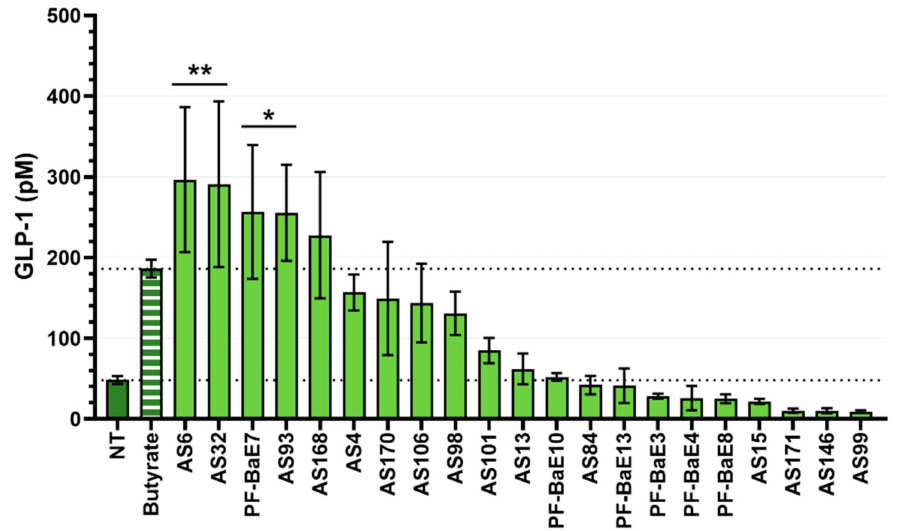
Figure 5. Production of GLP-1 in the supernatants of STC-1 cells stimulated by the selected strains. Cells were stimulated 8 h with the bacteria (MOI 10:1) or with butyrate (10 mM) as a positive control (Butyrate) then GLP-1 concentration was measured by Multiplex. * p < 0.05; ** p < 0.01 in comparison with untreated cells